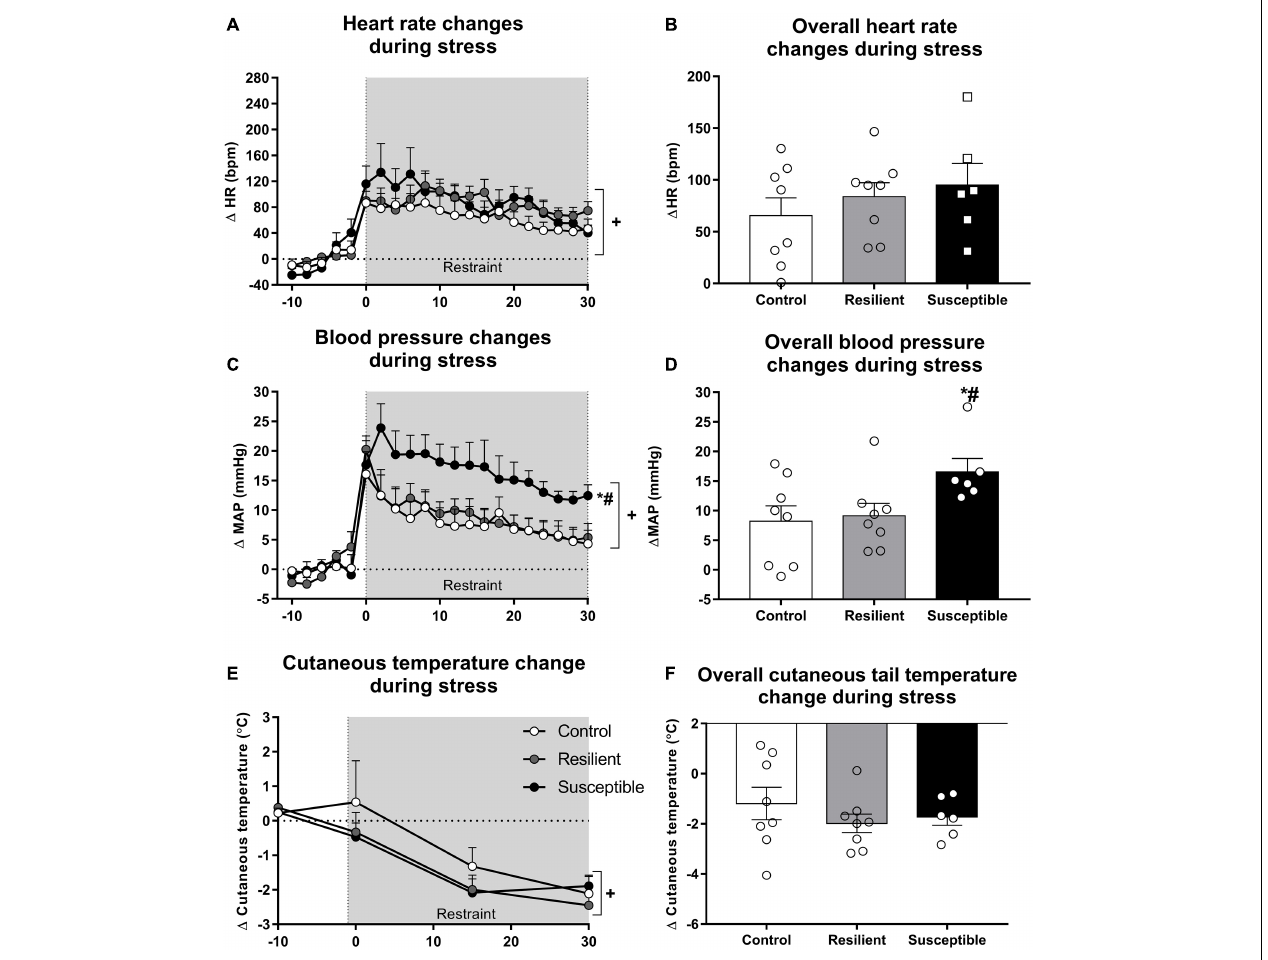
FIGURE 3 | Heart rate (HR), blood pressure, and cutaneous tail temperature changes during restraint stress in resilient and susceptible phenotypes to SDS. Animals were cannulated 48 h after the last social defeat episode, and cardiovascular parameters were recorded 24 h later. Points represent means + SEM ( n = 6–8 animals per group). The values were expressed as changes from the mean basal value, obtained for 10 min. (A) HR changes during restraint stress exposure. (B) Overall HR changes during restraint stress exposure. (C) Mean arterial pressure (MAP) changes during restraint stress exposure. (D) Overall MAP changes during restraint stress exposure. (E) Cutaneous tail temperature changes during restraint stress exposure. (F) Overall cutaneous tail temperature changes during restraint stress exposure. * p < 0.05 relative to control group; # p < 0.05 relative to resilient group; + significant restraint stress effect.